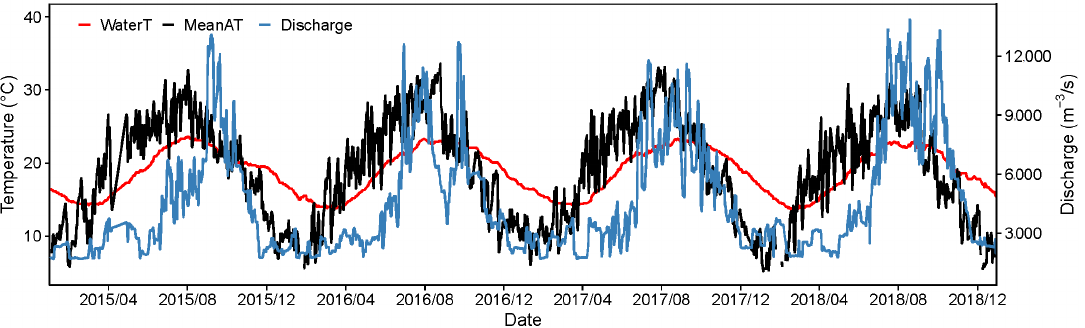
Figure 2. Time series plot of water temperature (red lines), mean air temperature (black lines), and discharge (blue lines)